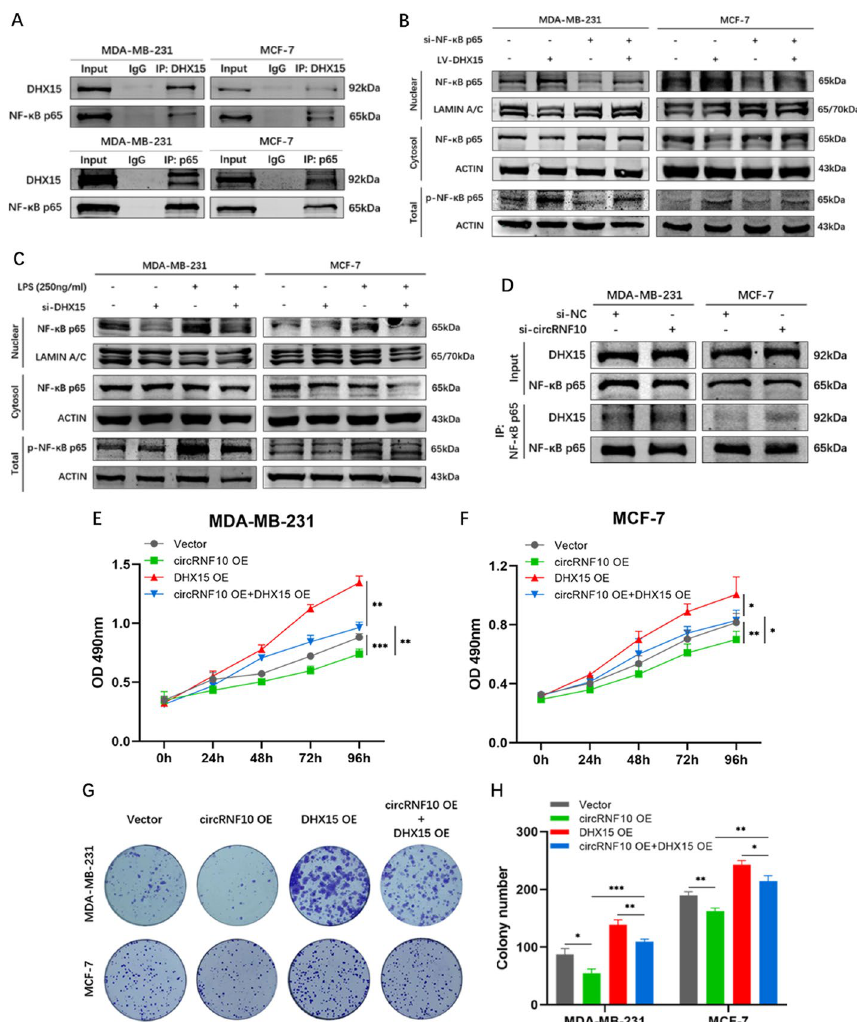
Fig. 5 CircRNF10 inhibited BC progression by antagonizing DHX15-p65 interaction. A Co-IP assay detecting the interaction between endogenous DHX15 and p65 in BC cells. B Western blotting analysis presenting the influence of LV-DHX15 on the p-p65 (S536) levels in total protein and the cytoplasmic and nuclear p65 levels, when p65 was suppressed in BC cells. C Western blotting analysis presenting the influence of si-DHX15 on the p-p65 (S536) levels in total protein, and the cytoplasmic and nuclear p65 levels when BC cells were treated with LPS (250 ng/ml). D Co-IP assay presenting the change of DHX15-p65 interaction after inhibiting circRNF10 in BC cells. E MTT assay showing the influence of circRNF10 overexpression on the proliferation of DHX15 overexpressed MDA-MB-231 cells. F MTT assay showing the influence of circRNF10 overexpression on the proliferation of DHX15 overexpressed MCF-7 cells. G Colony formation assay showing the effect of circRNF10 overexpression on the proliferation of DHX15 overexpressed BC cells. H The number of colonies. Error bars represent the mean SD. * P < 0.05, ** P < 0.01, *** P < 0.001, **** P < ±